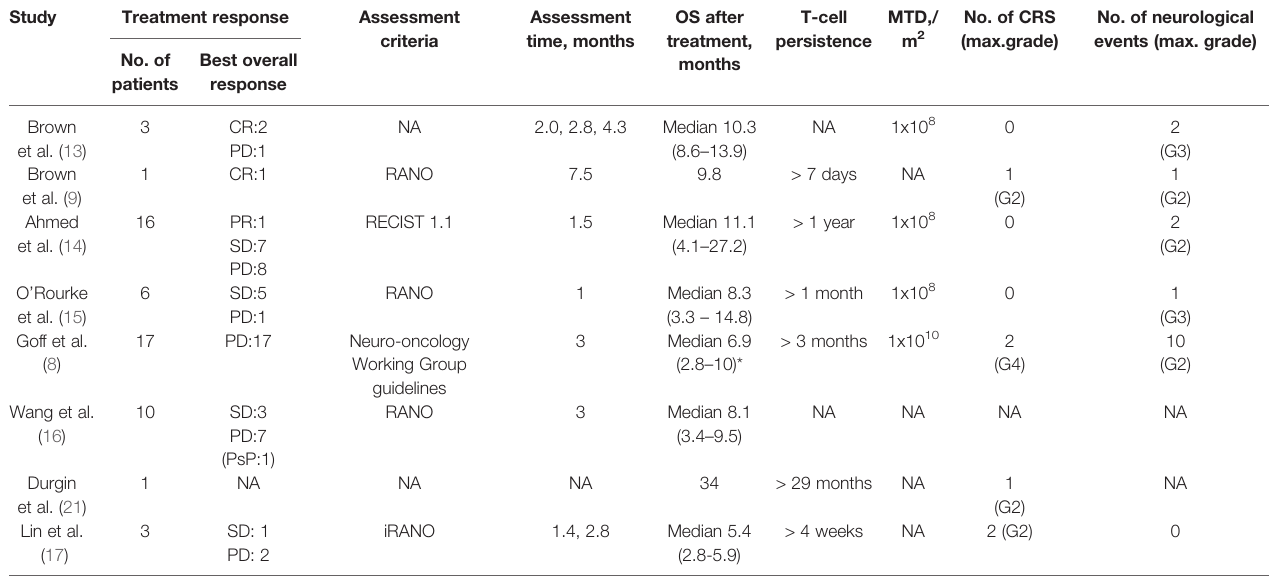
TABLE 2 | Treatment results following chimeric antigen receptor-T-cell